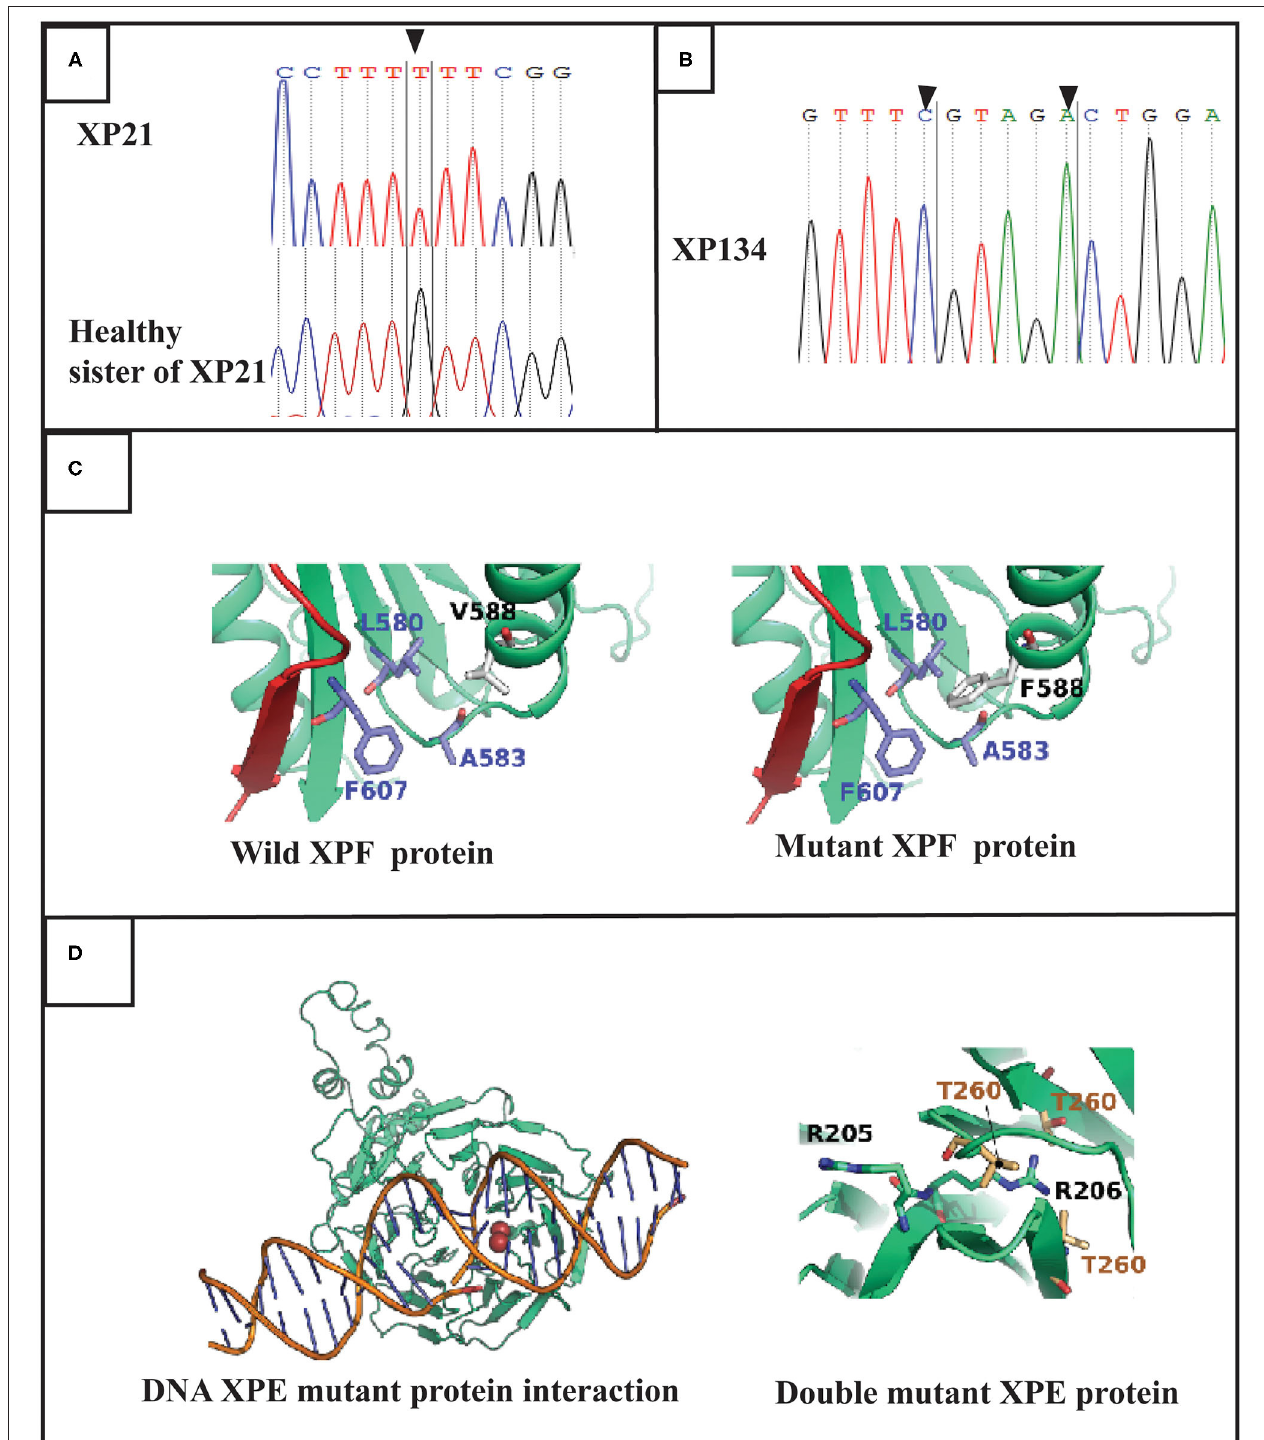
FIGURE 2 | Molecular findings: (A) Electropherogram showing the variation in ERCC4 gene in exon 8 (c.1762 G > T p.V588F) at a homozygous state in the patient XP21. (B) Electropherogram showing double variation in DDB2 gene (c.613 T > C p.C205R and c.618 C > A p.S206R) in exon 5 in XP134 patient. (C) Structures of the XPF protein and F588 XPF mutant suggesting a mild distortion in helix domain. (D) DNA DDB2 protein interaction for muted DDB2 protein suggestion that R206 affect this process.